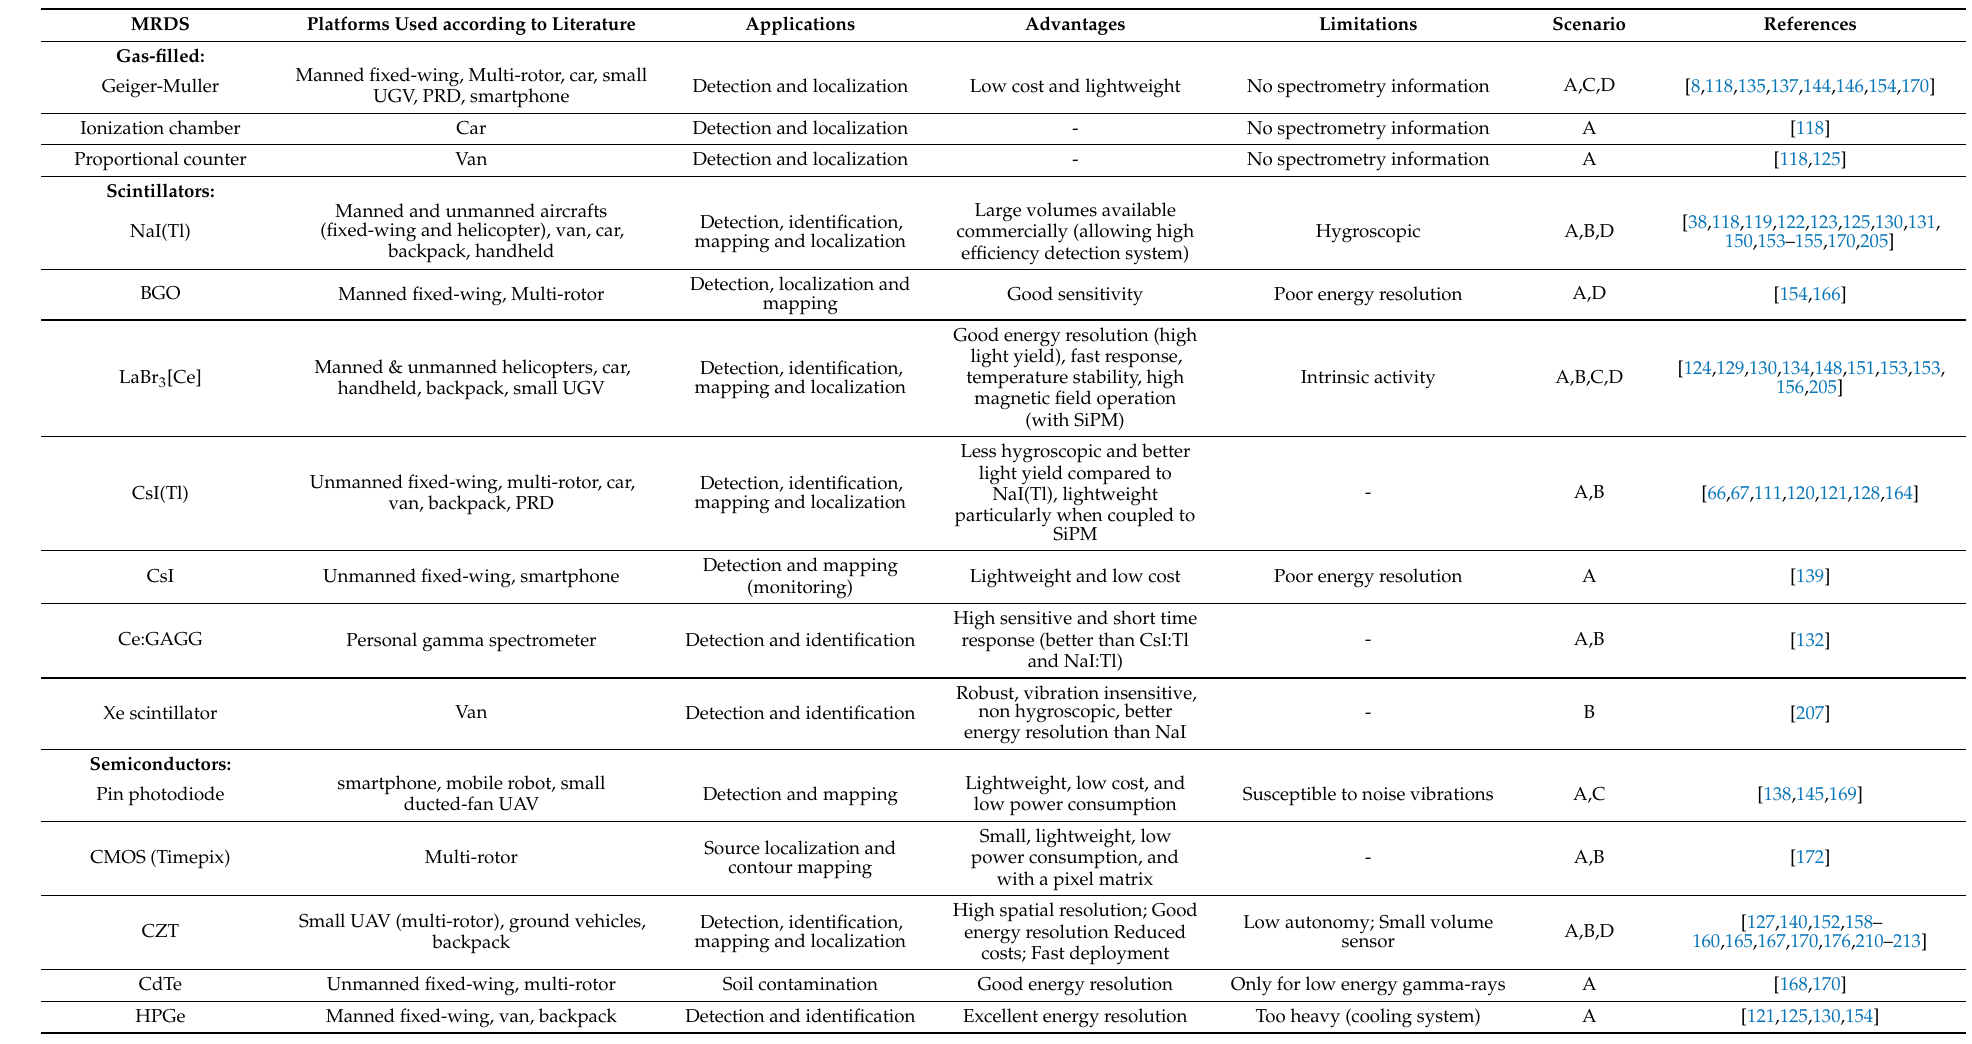
Table 7. Advantages and limitations of the mobile radiation detection systems described in literature used in the different scenarios (described in Section